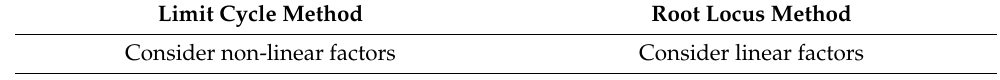
Table 3. The limit cycle method and root locus method.